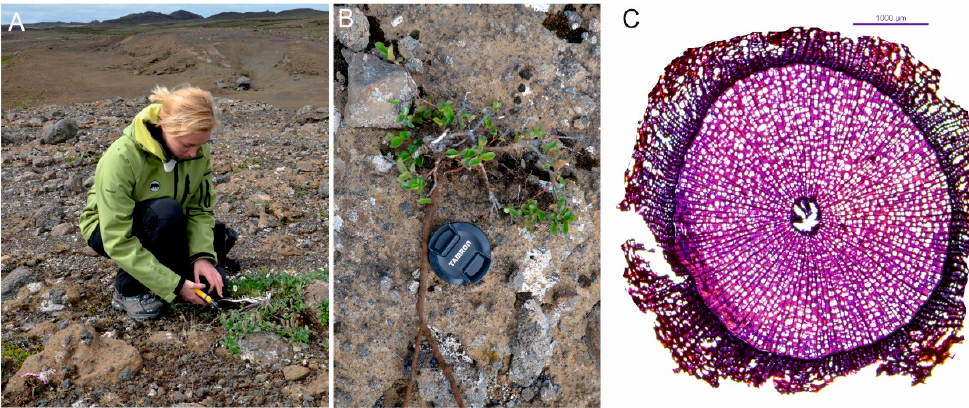
Figure 2. ( A ) Polar willow sampling in the Afrétt site, Northeastern Iceland; ( B ) dwarf willow spec- imen containing the root, root collar, and wooden branches collected for laboratory analysis; ( C ) example of a microscopic cross-section of dwarf